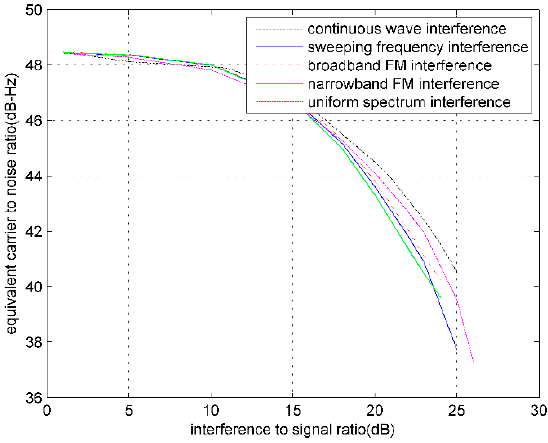
Figure 3. Influences of different RFIs on equivalent C { N